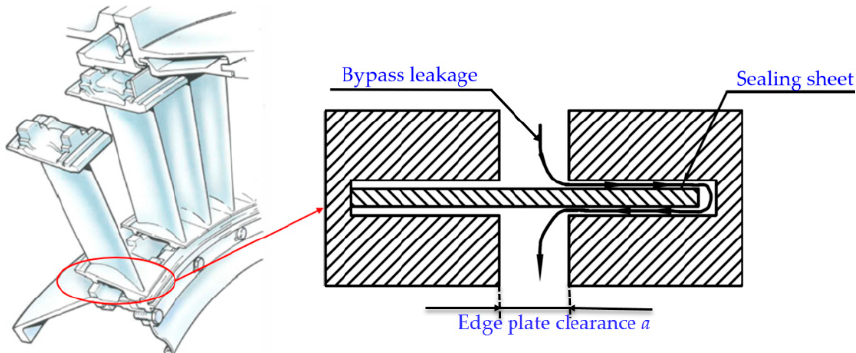
Figure 7. Schematic diagram of bypass leakage (circumference leakage) for the sealing sheet. (4) Leakage length proportion Y : c Y = L